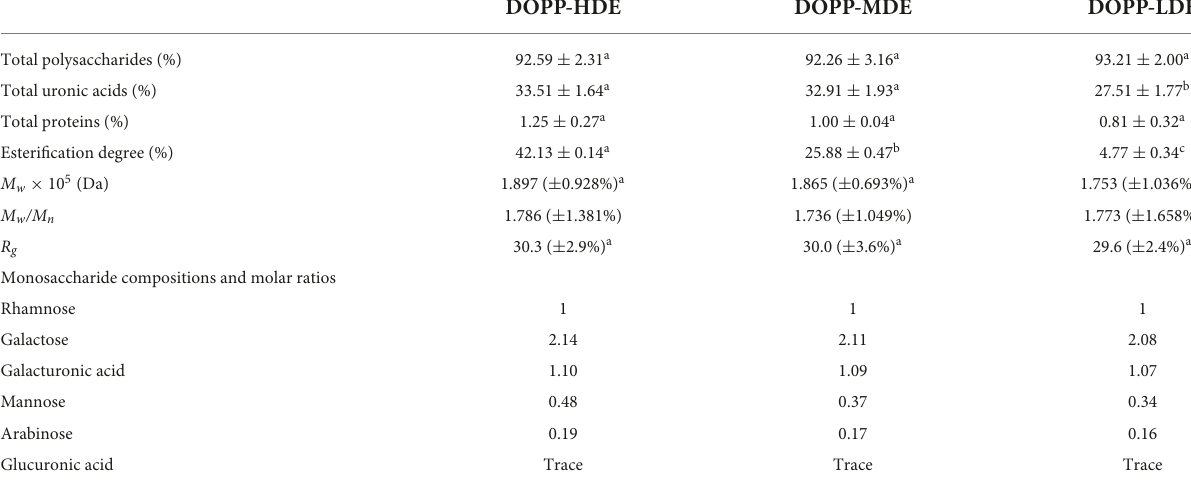
TABLE 1 Chemical composition, molecular weight ( M w ), polydispersity ( M w /M n ), radius of gyration ( R g ), and constituent monosaccharide of okra pectic-polysaccharides (OPP) with various degrees of